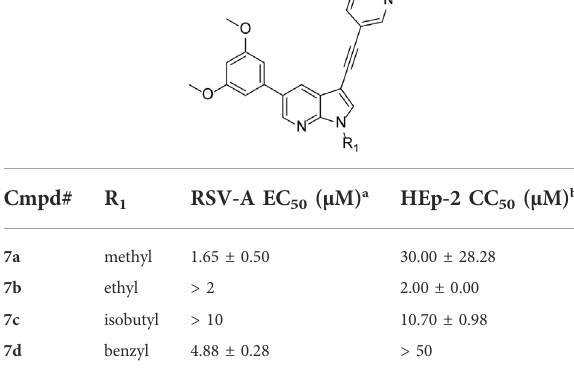
(Table 3). Unfortunately, none of the structural modi fi cations yielded analogues with an attractive pro fi le. Several congeners (compounds 5a - c and 5f ) were cytotoxic and lacked selective antiviral activity. The 7-aza-indoles with a 3-chloro- (compound 5d ) or 3-methoxy (compound 5e ) phenylacetylene substituent at